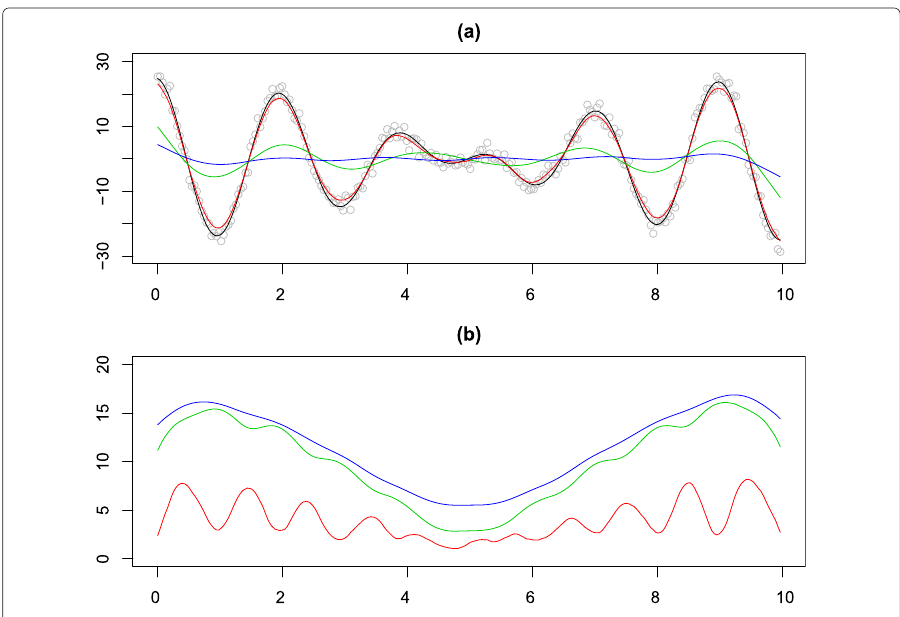
Fig. 7 a Noisy sequence (open circles), true function (black line), EAve τ t ( X t ) by τ = 8 (red line), τ = 32 (green line), τ = 64 (blue line), and b Esd τ t ( X t ) by τ = 8 (red line), τ = 32 (green line), τ = 64 (blue